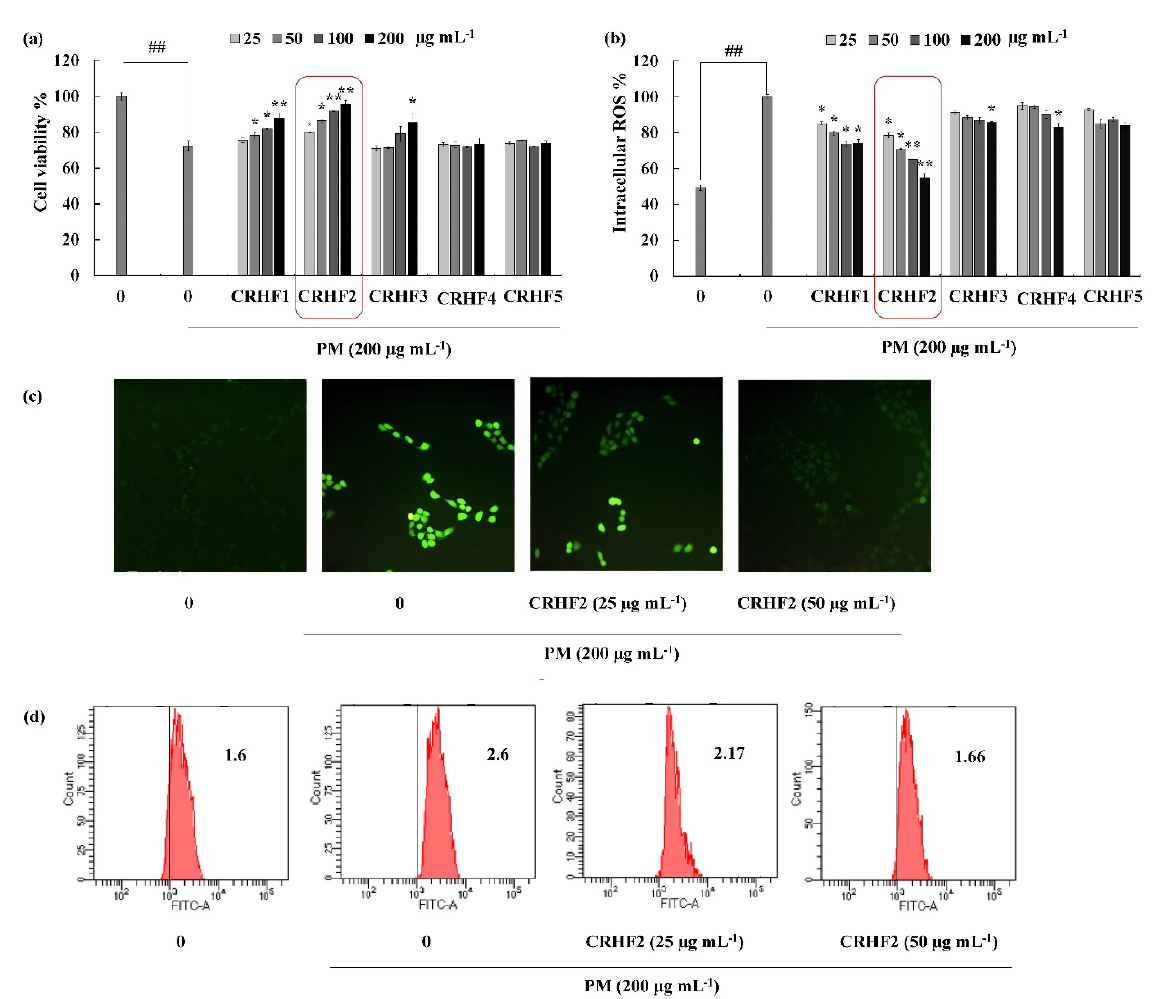
Figure 2. CRHF2 protects PM-induced oxidative stress in HaCaT keratinocytes. Effect of column fractions on ( a ) cell viability and ( b ) intracellular ROS levels, ( c ) fluorescence microscopy images, and ( d ) flow cytometry results of DCFH2-DA stained cells. The values in the histogram represent the mean intracellular ROS levels. Results are represented as mean ± SD of triplicate determinants (n = 3); * p < 0.05, ** p < 0.01. (# denotes significance compared to control while * represents significance compared to PM-treated group).